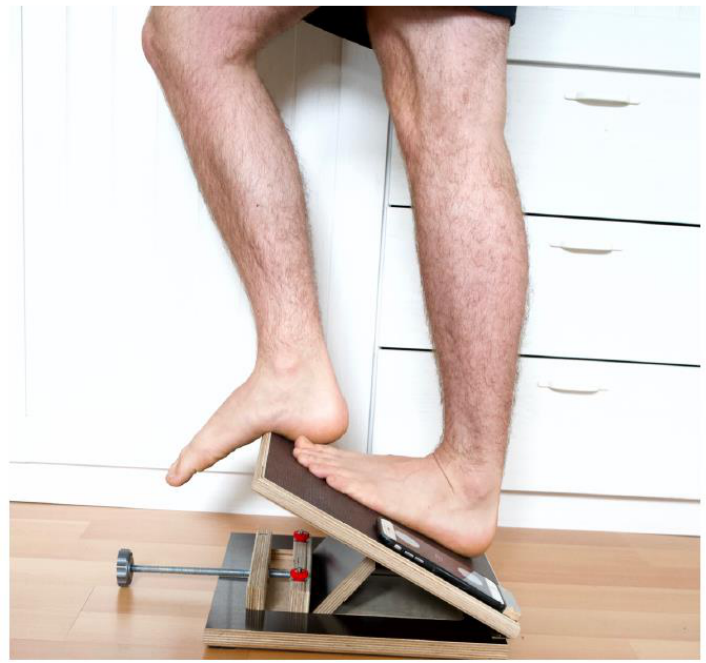
Figure 2. Using a stretching board for stretching the plantar flexors.